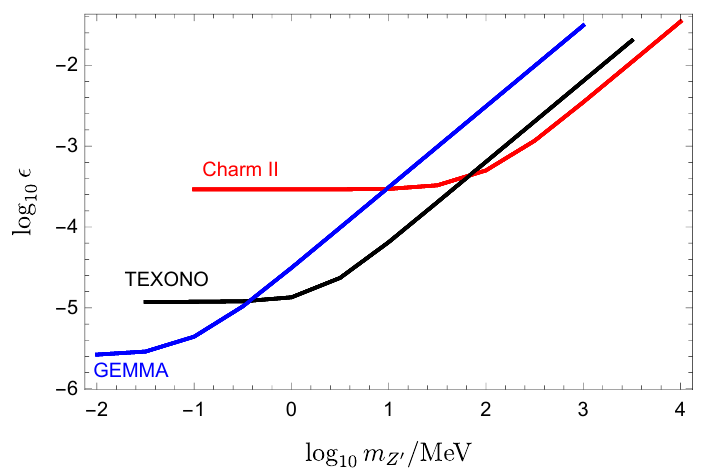
Figure 3 . Constraints on (cid:15) when g X = (cid:11) = 0. The result in this case is independent of the U(1) X charge